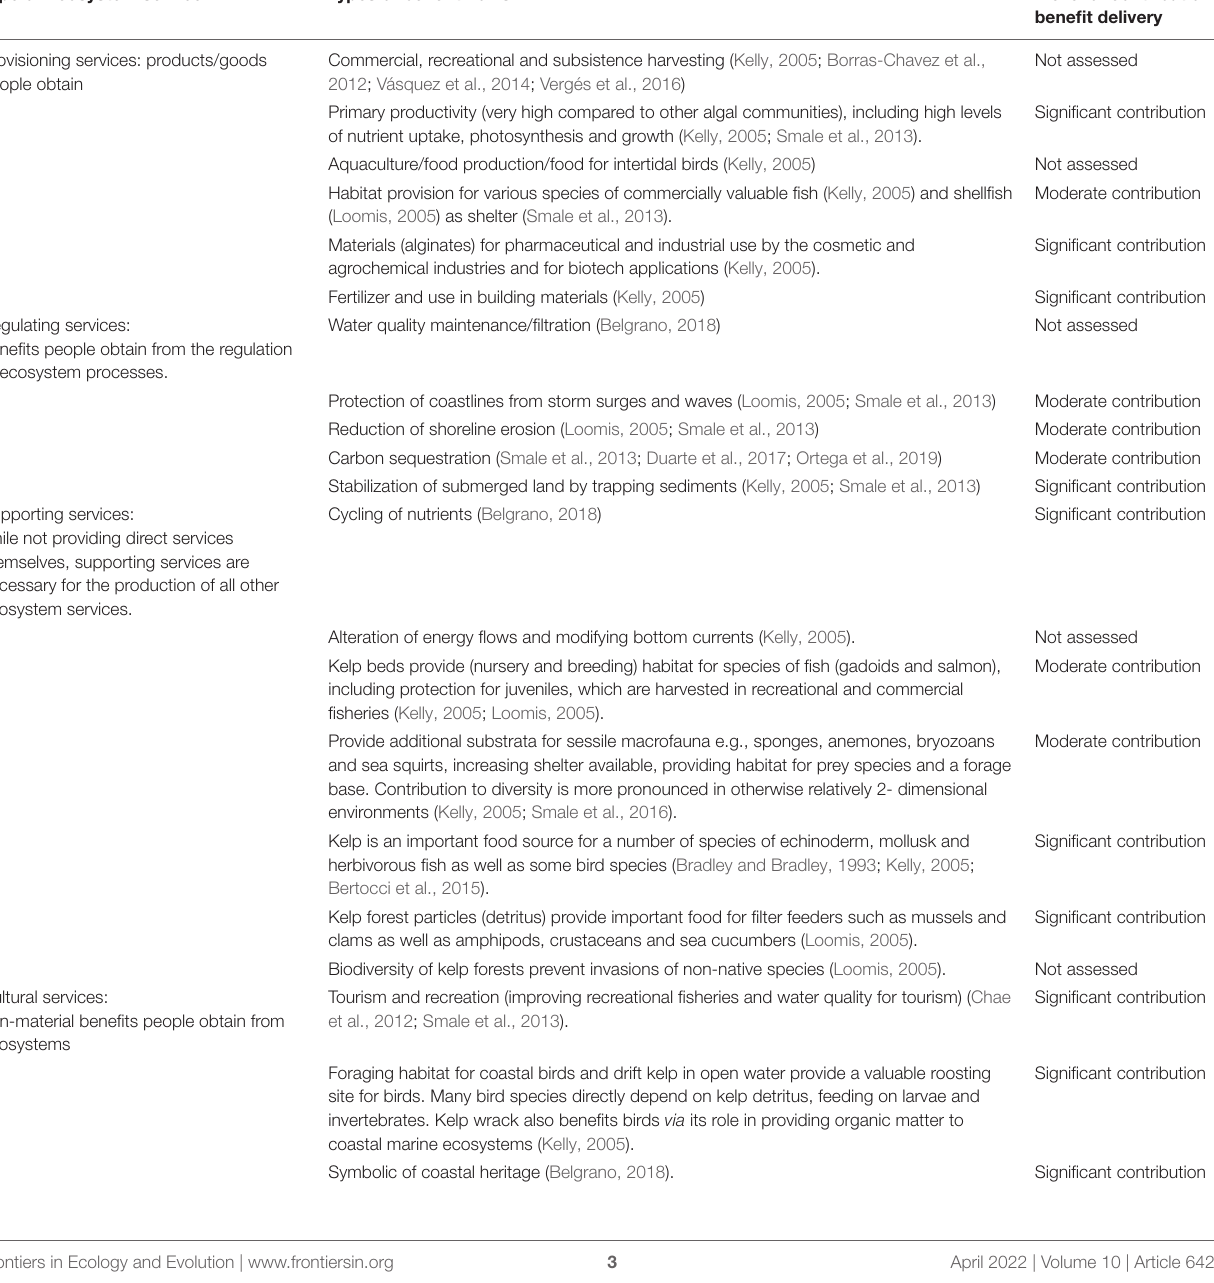
TABLE 1 | Ecosystem services (ES) provided by Kelp forests globally and their level of contribution to benefit